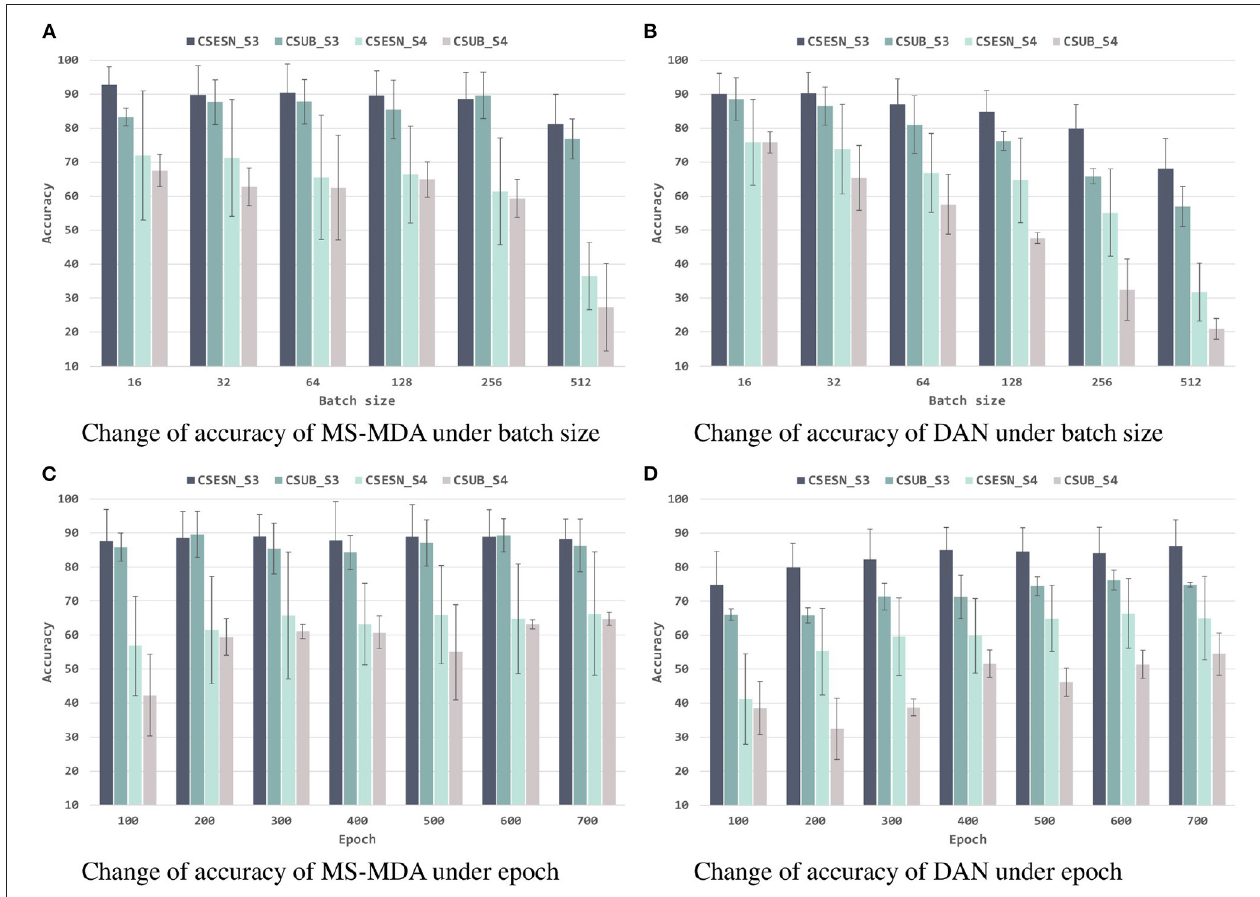
FIGURE 6 | Evaluation of MS-MDA and DAN. The four color bars from left to right correspond to the four transfer scenarios: cross-session for SEED, cross-subject for SEED, cross-session for SEED-IV, cross-subject for SEED-IV. Batch size: { 16,32,64,128,256,512 } , epoch: { 100,200,300,400,500,600,700 } . (A) Change of accuracy of MS-MDA under batch size. (B) Change of accuracy of DAN under batch size. (C) Change of accuracy of MS-MDA under epoch. (D) Change of accuracy of DAN under